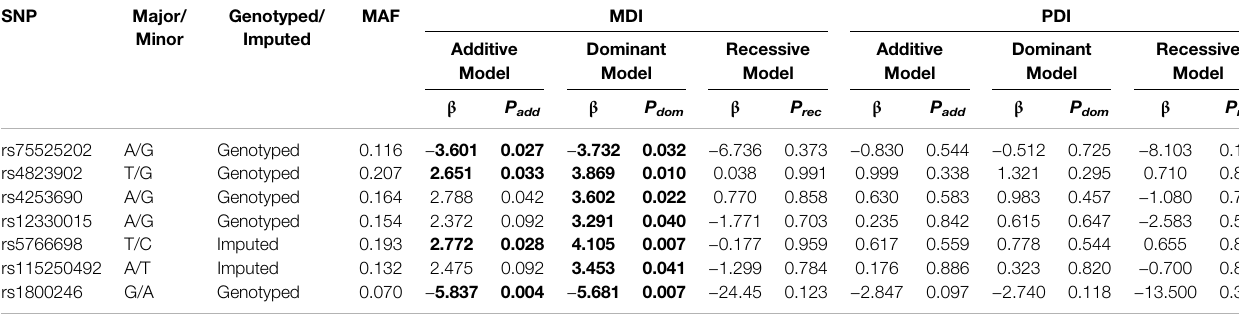
TABLE 4 | Associations of the seven selected PPAR α variants with neurocognitive